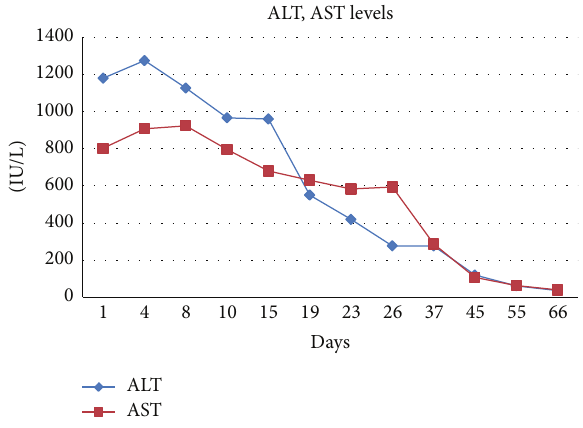
Figure 2: Changings of ALT and AST levels.